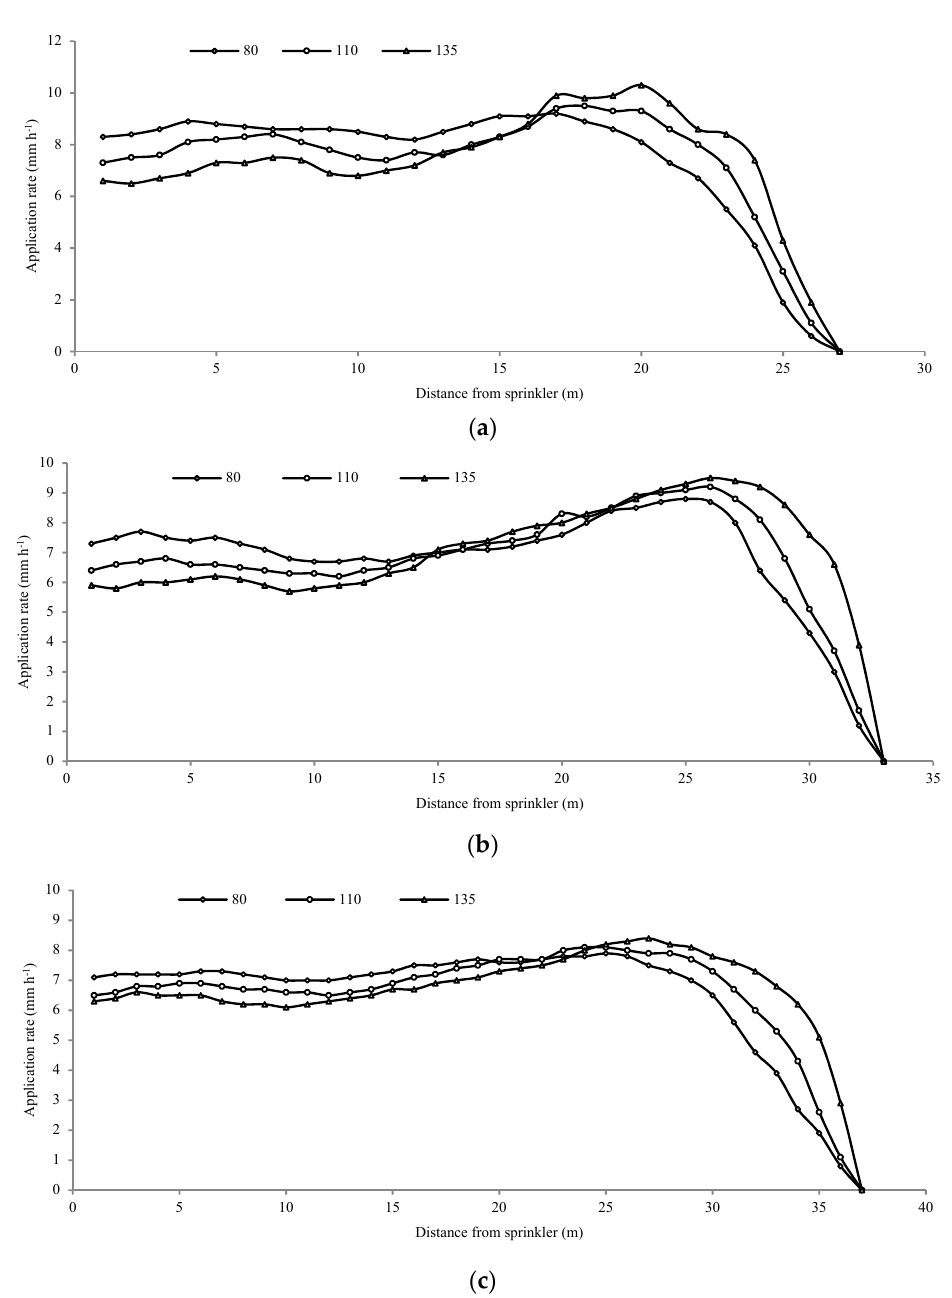
Figure 7. Water distribution patterns with different counterweight-installed positions: ( a ) working pressure of 0.30 MPa; ( b ) working pressure of 0.35 MPa; ( c ) working pressure of 0.40 MPa.